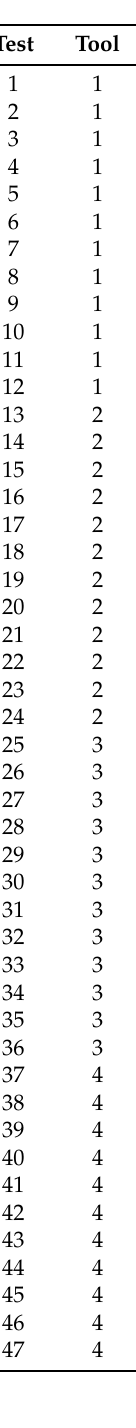
Table 3. Results for thrust force and burr